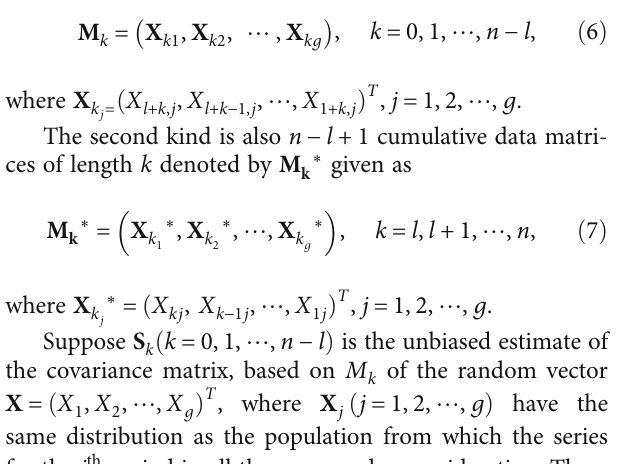
Figure 1: The box plots for the volatilities obtained from the three